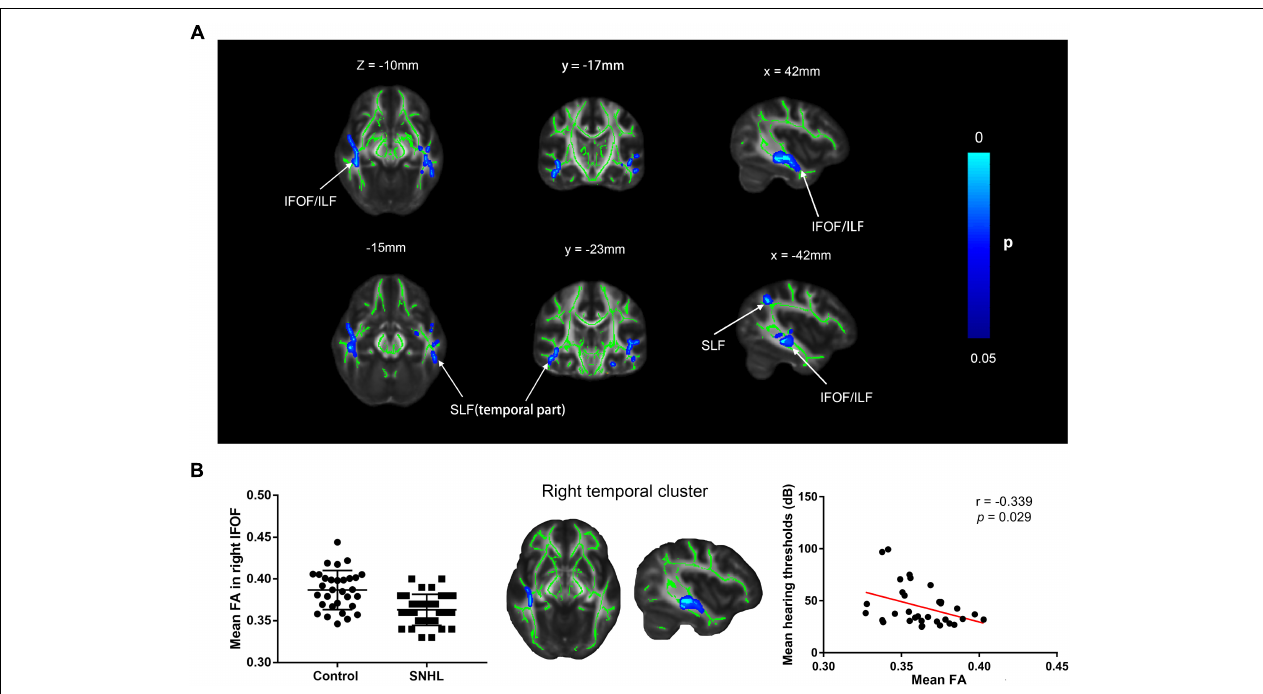
FIGURE 6 | (A) Distribution map of the FA value that was significantly lower in the SNHL group compared with the control group based on the TBSS analysis. The mean FA skeleton (green) is overlaid with the blue clusters denoting significantly decreased FA values in patients with SNHL. The color bar on the left presents the p -value. The mean FA values in the significant cluster of the right temporal lobe are positively correlated with the binaural mean hearing thresholds in patients with SNHL, after controlling for the effects of the age, sex, and education (B) . FA, fractional anisotropy; IFOF, inferior fronto-occipital fasciculus; ILF, inferior longitudinal fasciculus; SLF, superior longitudinal